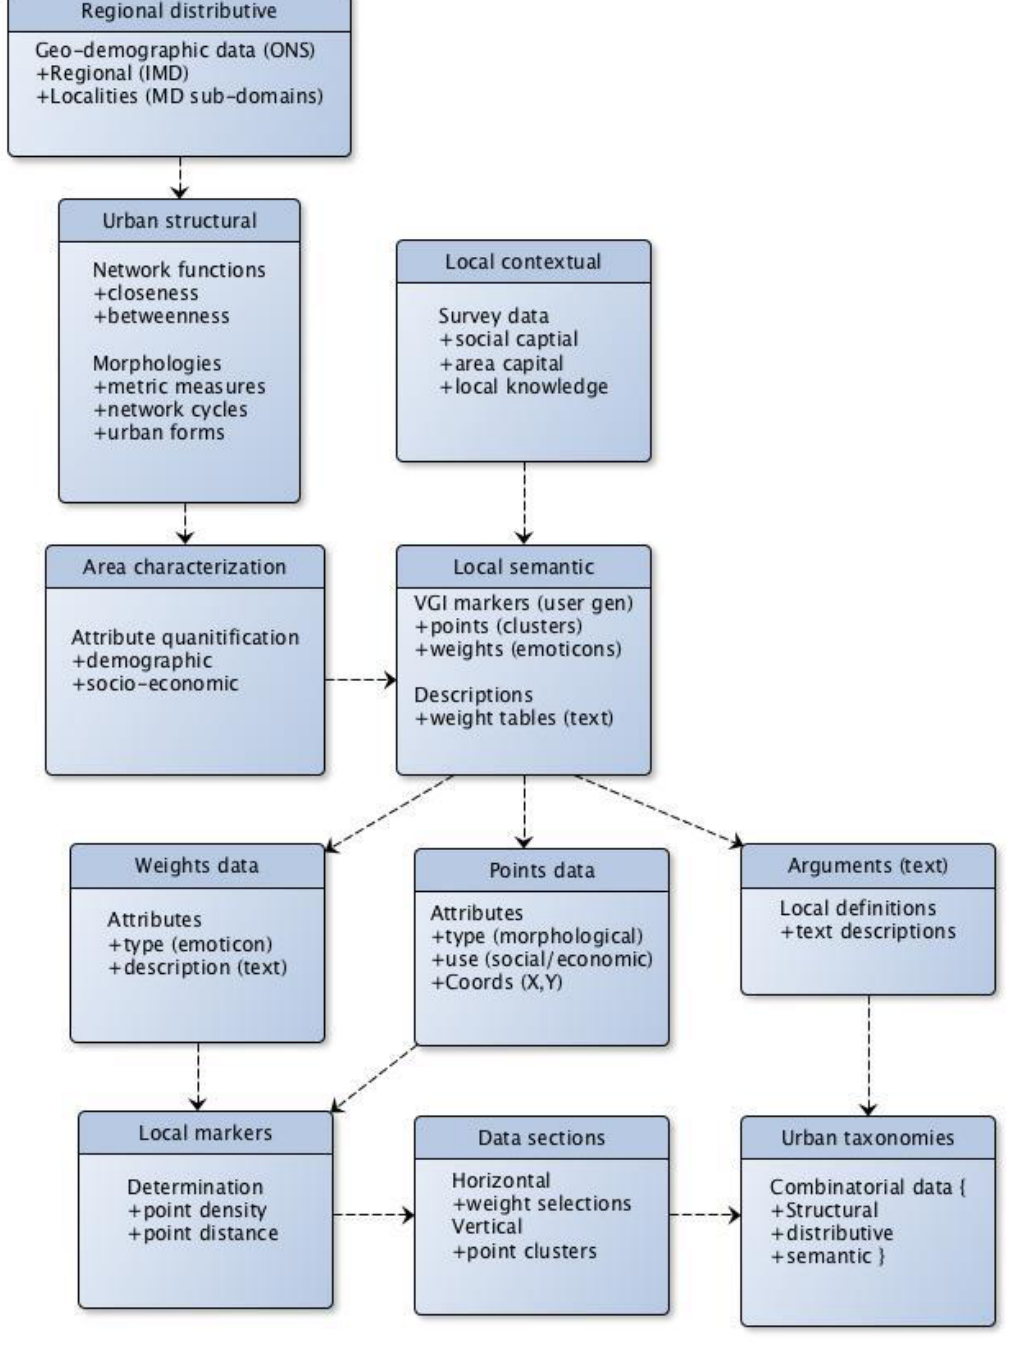
Figure 5. Methodological data model (‘VCI project’). The model shows how a range of data flows into the study’s urban community analysis, forming the basis for gathering voluntary point data and text data. It shows how ‘local semantic’ data is gathered from the participatory workshops, including the geo-locations (points) and characteristics (weights) of the emoticon stickers, the urban artefacts they represent, and their text descriptions. Finally, the processed points data will be used to taxonomize the range of artefacts selected in terms of comparative demographic and structural characteristics. In this way, the VGI data is captured traceably within a well-defined, multi-layered